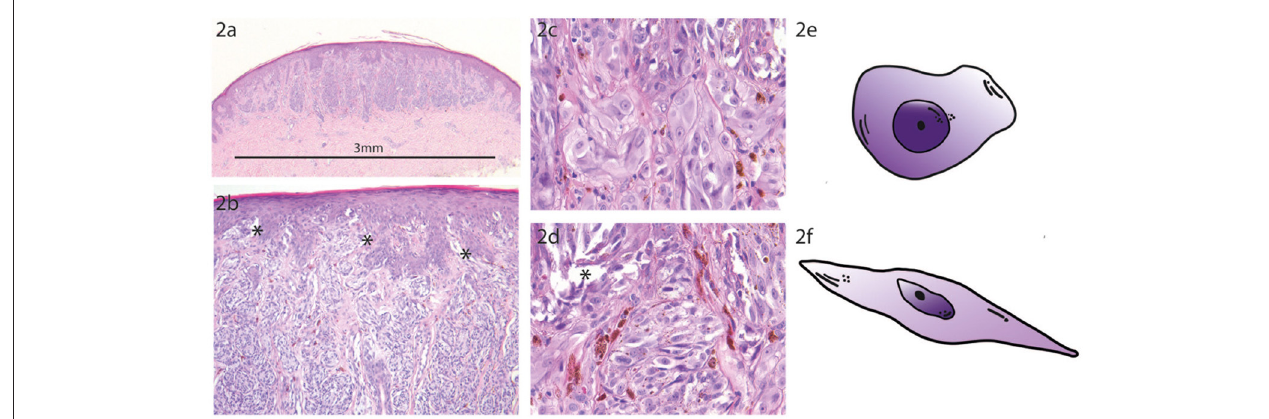
FIGURE 2 | Prototypic Spitz Nevus. (a) The compound Spitz nevus (SN) has a small size of 3mm with a symmetric dome shaped morphology and shows sharp lateral demarcation (H.E. staining, magnification factor 2.5x). (b) Higher magnification from A shows regular epidermal hyperplasia with vertically orientated fascicles of spindled and epithelioid melanocytes. Note the numerous epidermal junctional clefts (*) which are formed due to discohesion of the melanocytes (H.E. staining, magnification factor 10x). (c) Higher magnification from B with uniform characteristic epithelioid melanocytes at the epidermal junction (H.E. staining, magnification factor 40x). (d) Higher magnification from B showing regular spindle shaped melanocytes at the epidermal junction with formation of junctional clefts (*) due to discohesion of the Spitzoid melanocytes (H.E. staining, magnification factor 40x). (e) Schematic sketch of a prototypic epithelioid shaped melanocyte which is characteristic for a SN. (f) Schematic sketch of a prototypic spindle shaped melanocyte which is characteristic for a